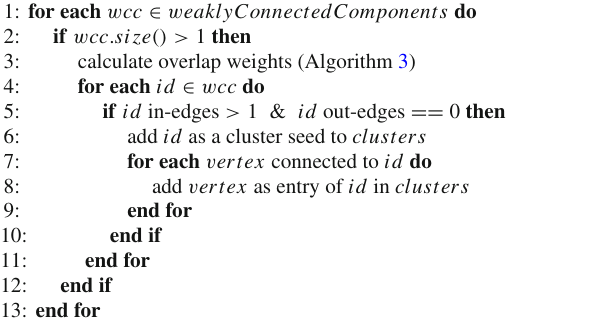
Algorithm 2 Analysis of connected components